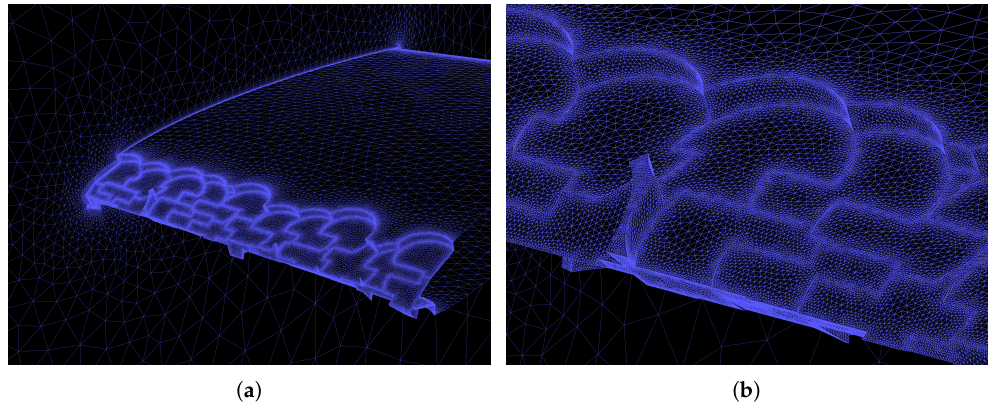
Figure 3. Mesh overview ( a ) and detail ( b ) of the three-dimensional geometry. The figures refer to the fine grid of 5 million elements.